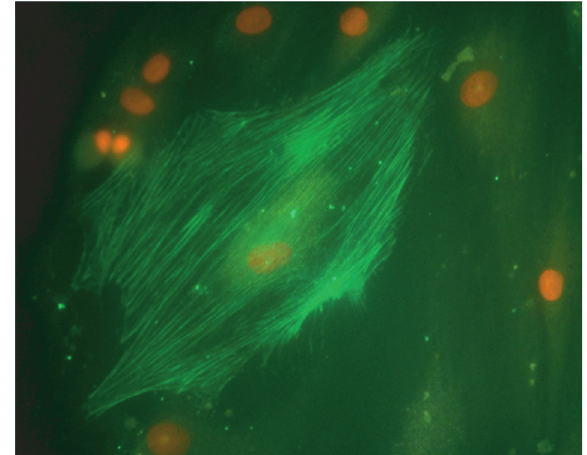
Figure 2: A human myofibroblast, × 40 magnification. The nucleus is stained orange with propidium iodide and the filaments of α - smooth muscle actin are immunostained green.